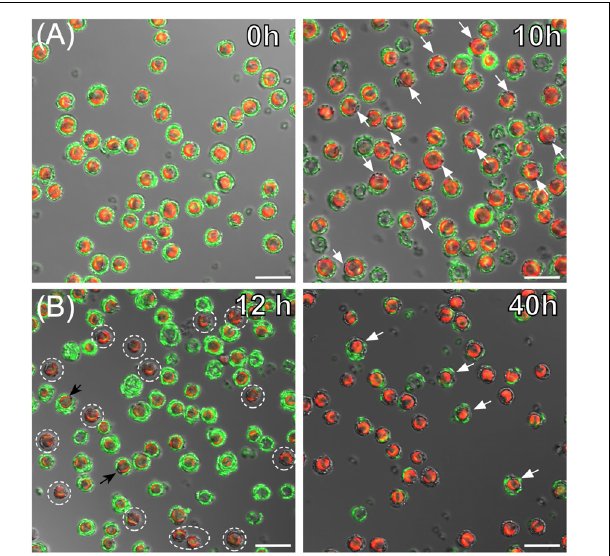
FIGURE 7 | Visualizing growth dynamics and calcification in exponential and stationary cultures of Emiliania huxleyi. (A) DIC, calcein (green), and chlorophyll (red) confocal overlay images of cells from an early exponential phase culture immediately after calcein staining (0 h left panel) and 10 h post-staining (right panel). By 10 h, the majority of cells have secreted new unstained coccoliths (examples indicated with white arrows). (B) Cells from a stationary phase culture after 12 h post-calcein staining in fresh nutrient replete media (left), and after 40 h in nutrient replete media (right). At 12 h a sub-set of cells (dotted circles) have calcified and are actively dividing among a population of cells that appear metabolically inactive as evidenced by intact, stained coccospheres. After 40 h in nutrient replete conditions all cells have resumed calcification and cell division which is supported by coccospheres with none or just 1–2 fluorescent coccoliths. A few cells (white arrows) still have the majority of their coccoliths labeled with calcein, suggesting a recent resumption of calcification compared to the majority of